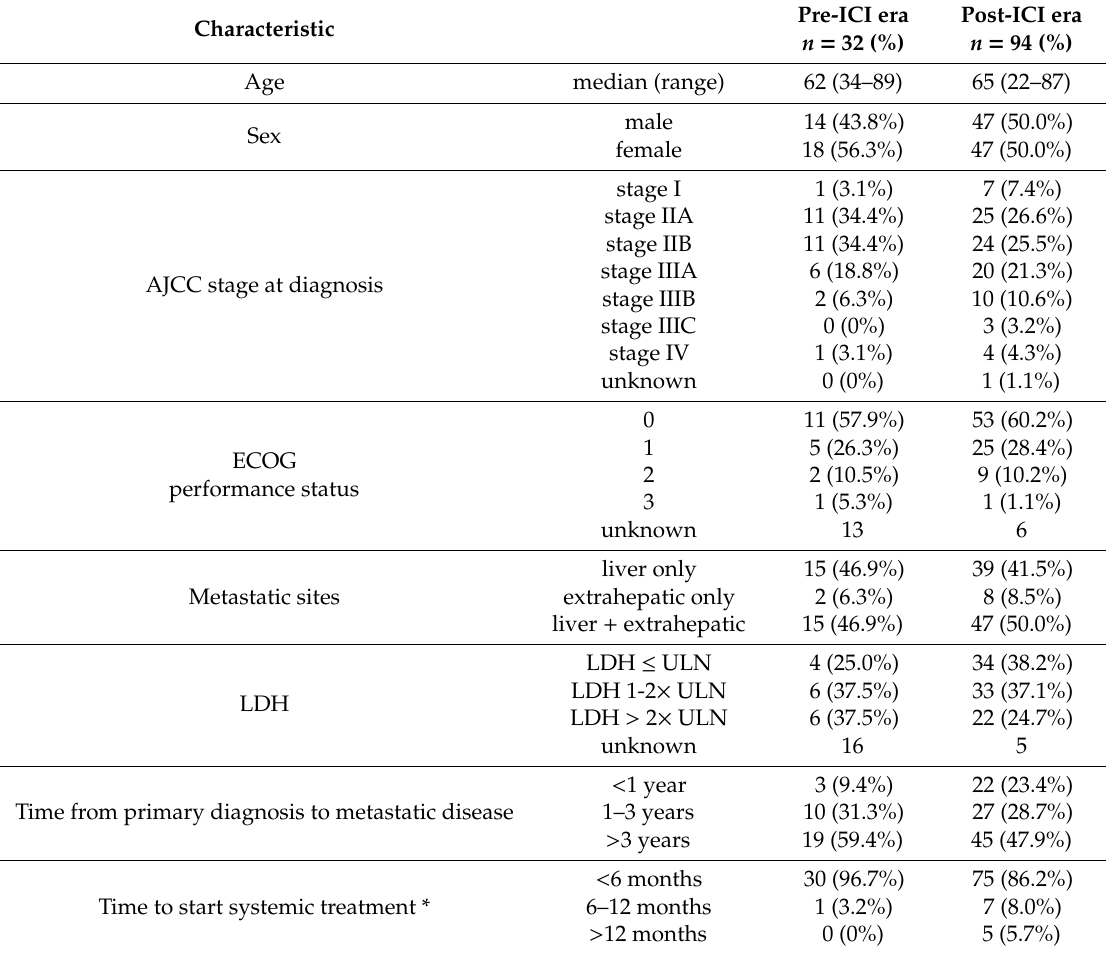
Table 1. Baseline